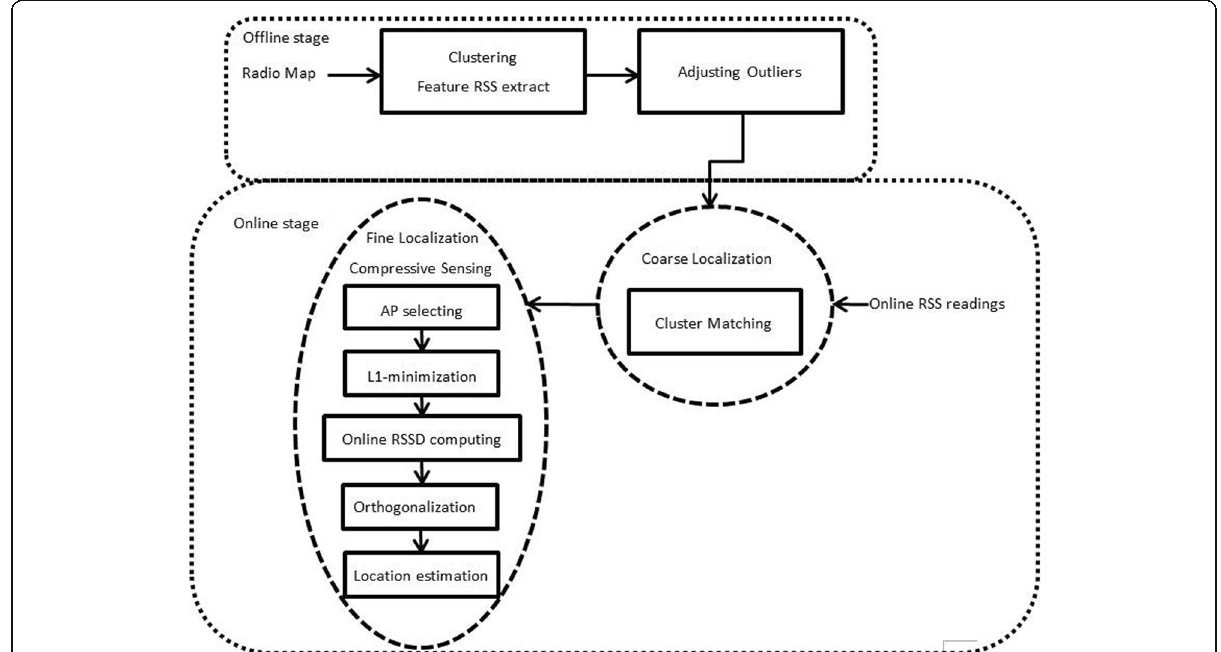
Fig. 3 Block diagram of the proposed indoor localization